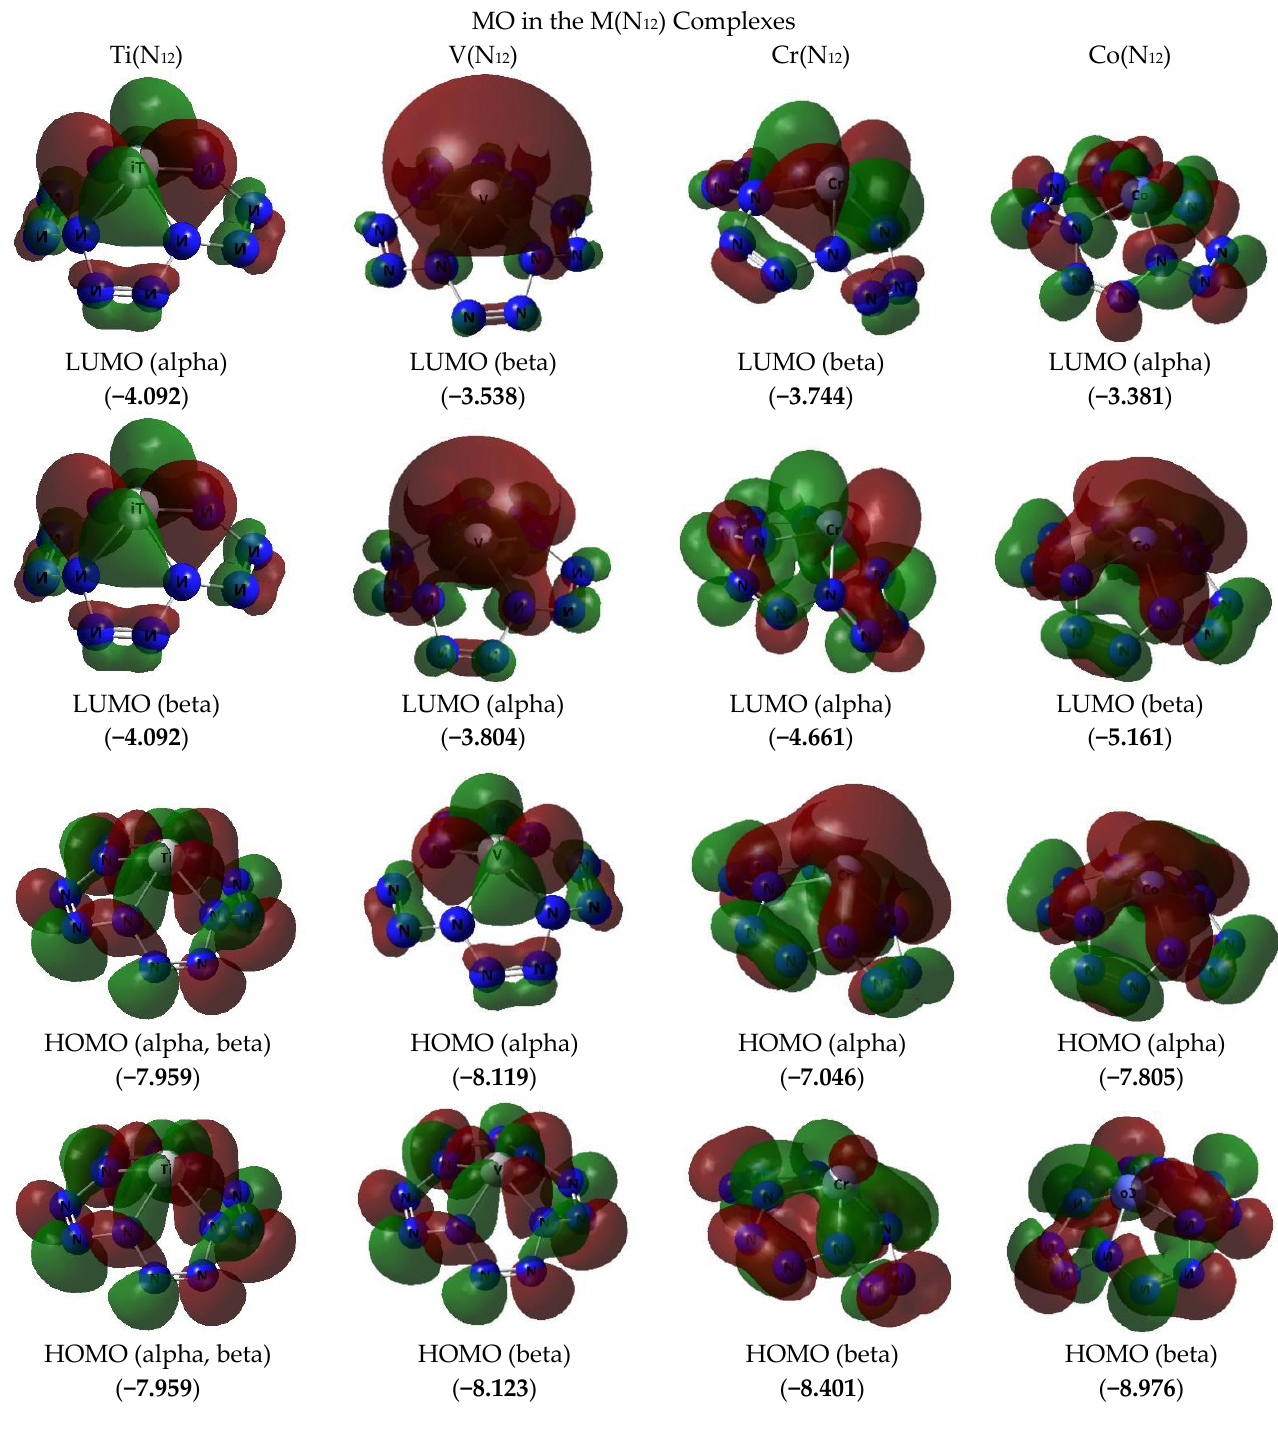
Figure 2. The images of highest occupied (HOMO) and lowest unoccupied (LUMO) molecular orbitals in the M(N 12 )] complexes of group A obtained by DFT M06/TZVP method. The values of energies of these molecular orbitals (in brackets) are given in eV. The symbol “alpha” corresponds to electron with spin (+1/2), “beta”, to electron with spin (−l/2).